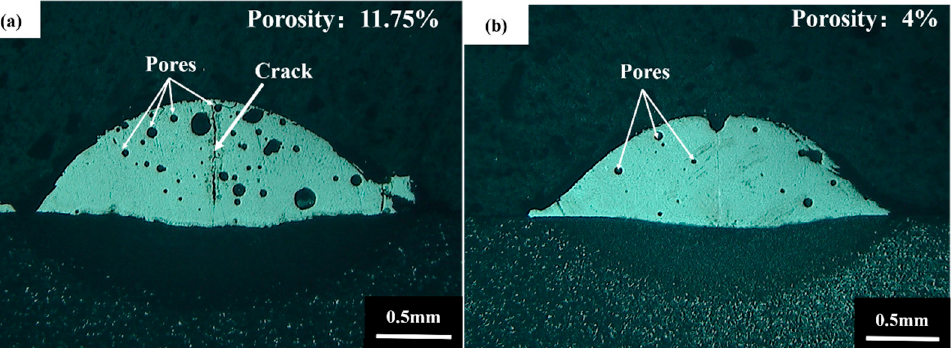
Figure 9. Coating morphologies: ( a ) without ultrasonic vibration; ( b ) with ultrasonic vibration (UP = 800 W, F = 32 kHz).